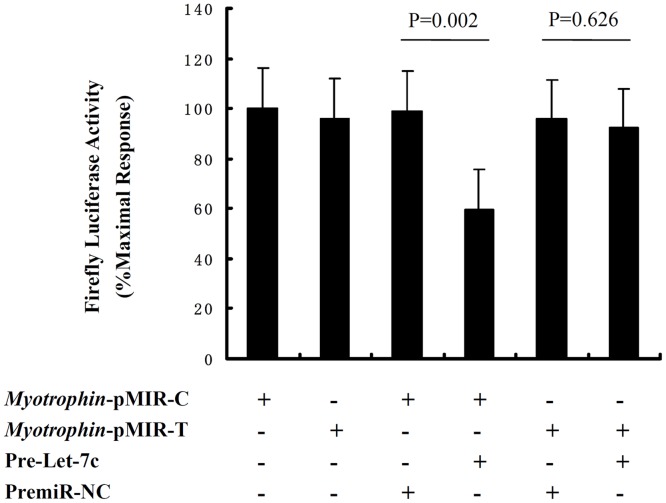
Testing the interaction between let-7c and myotrophin using a lucisferase reporter assay.Hela cells were co-transfected with myotrophin-pMIR-C or myotrophin-pMIR-T, and either negative control miRNA (PremiR-NC) or let-7c. 48 h after transfection, luciferase activities were measured. Firefly luciferase activity was normalized to Renilla luciferase expression, and mean activities ± S.E. from four independent experiments are shown. For myotrophin-pMIR-C transfection, PremiR-NC versus let-7c, P = 0.002; for myotrophin-pMIR-T transfection, PremiR-NC versus let-7c, P = 0.626.